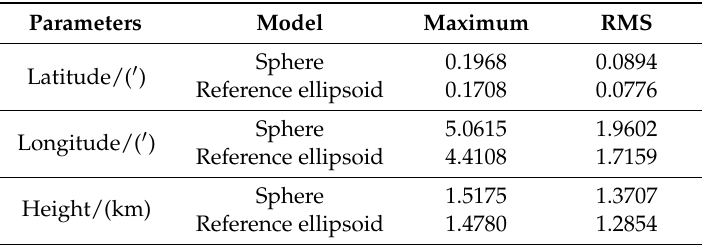
Figure 9. Navigation errors in high latitude regions: ( a ) grid SINS errors and integrated navigation errors; and ( b ) integrated navigation errors. Table 2. Integrated navigation position errors in the high latitude